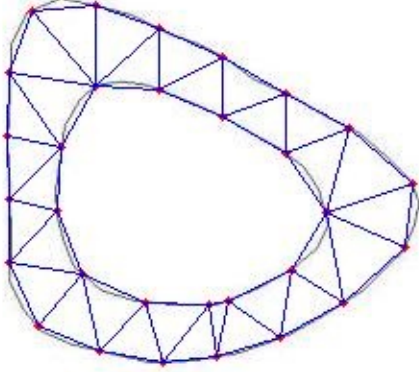
Figure 8. Finite element approach.